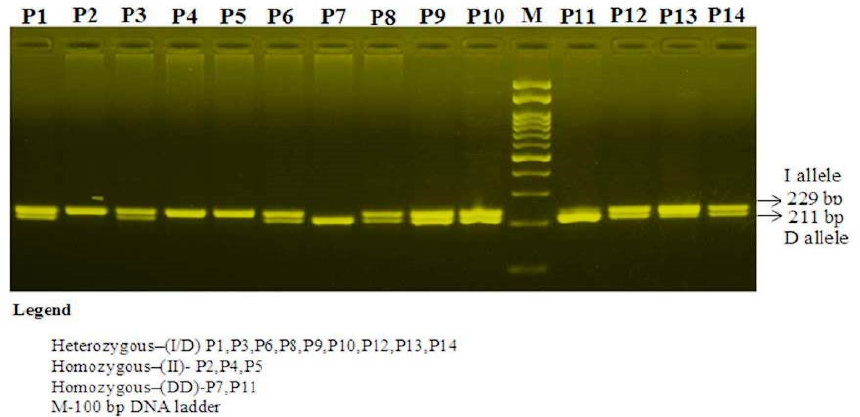
Figure 4. Mutation specific PCR for genotyping of VEGF I/D polymorphism in T2D subjects.